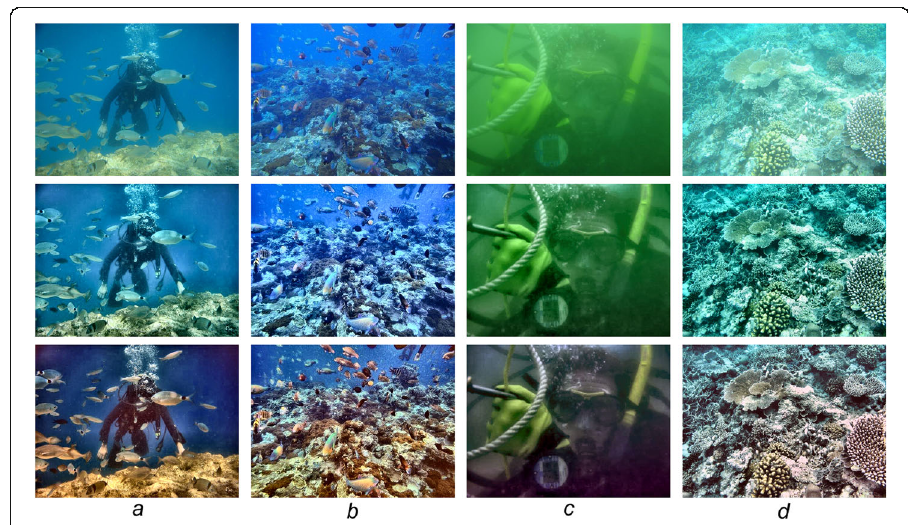
Fig. 5 Illustration of the effectiveness of the proposed color correction procedure in different underwater images. Top row: input images, middle row: restoration without color correction, bottom row: restoration with color correction